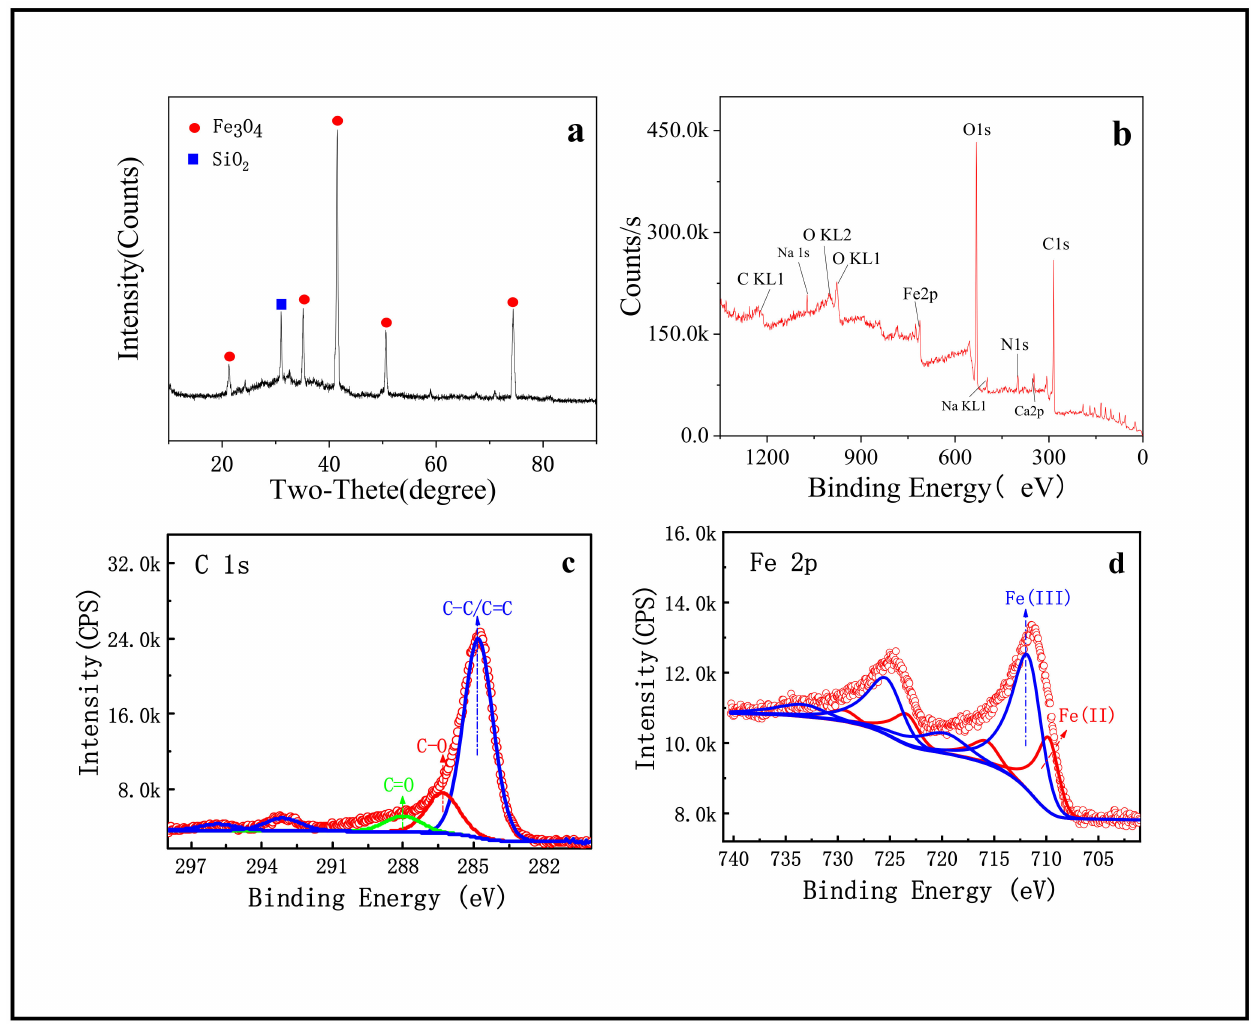
Figure 2. ( a ) XRD of SMB; ( b ) XPS of SMB; ( c ) C1s in high resolution spectrum of SMB; ( d ) Fe2p in high resolution spectrum of